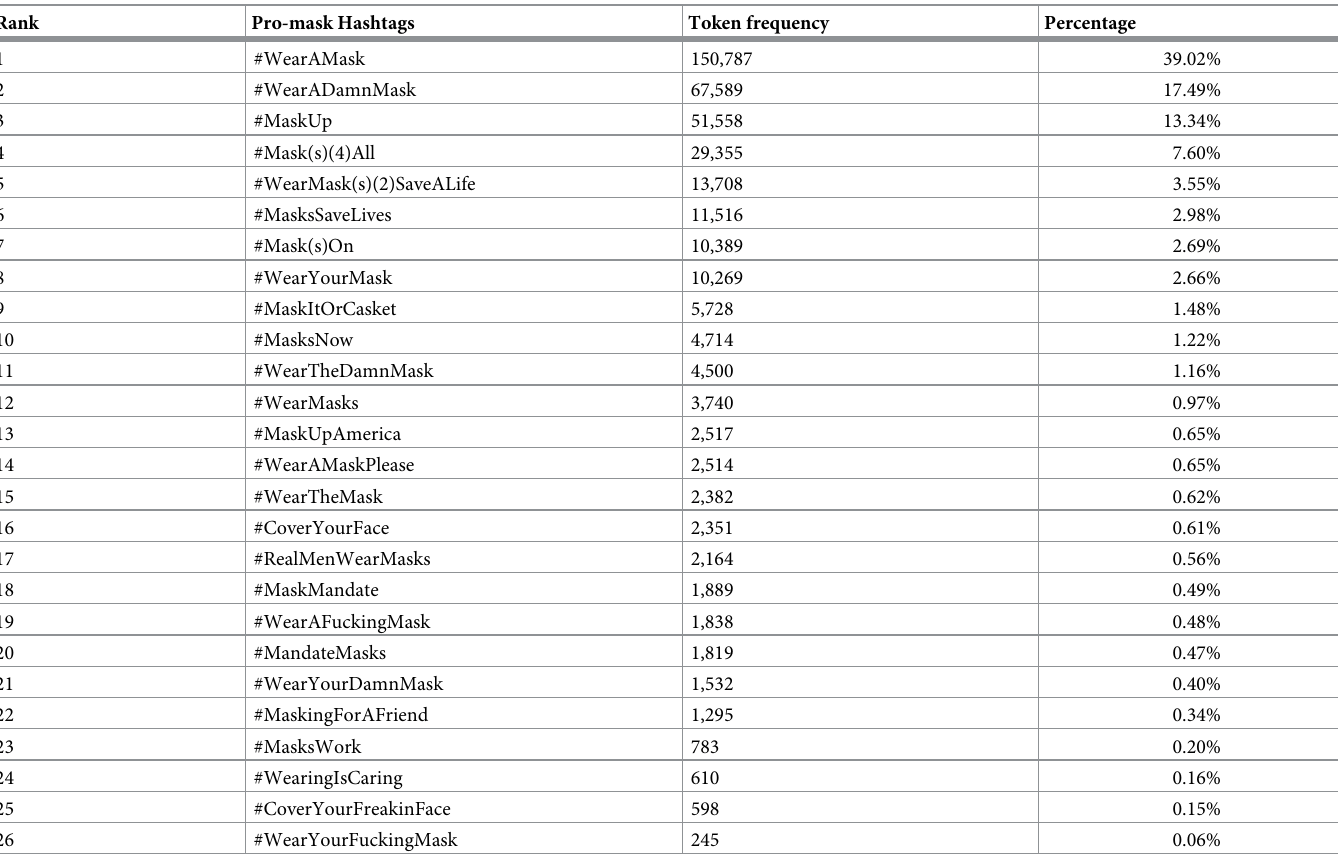
Table 1. 26 types of pro-mask hashtags ranked in token frequency.